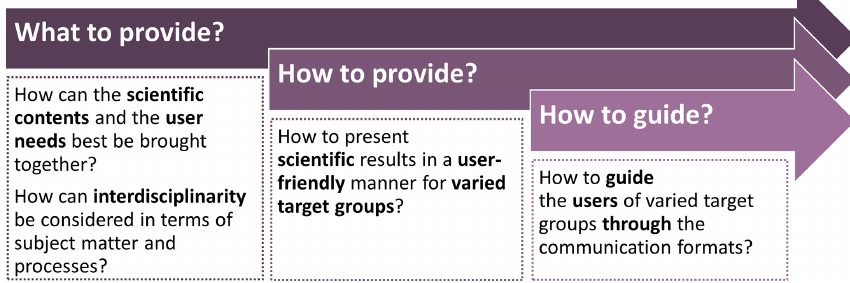
Figure 4. Summary of the DKTP development key